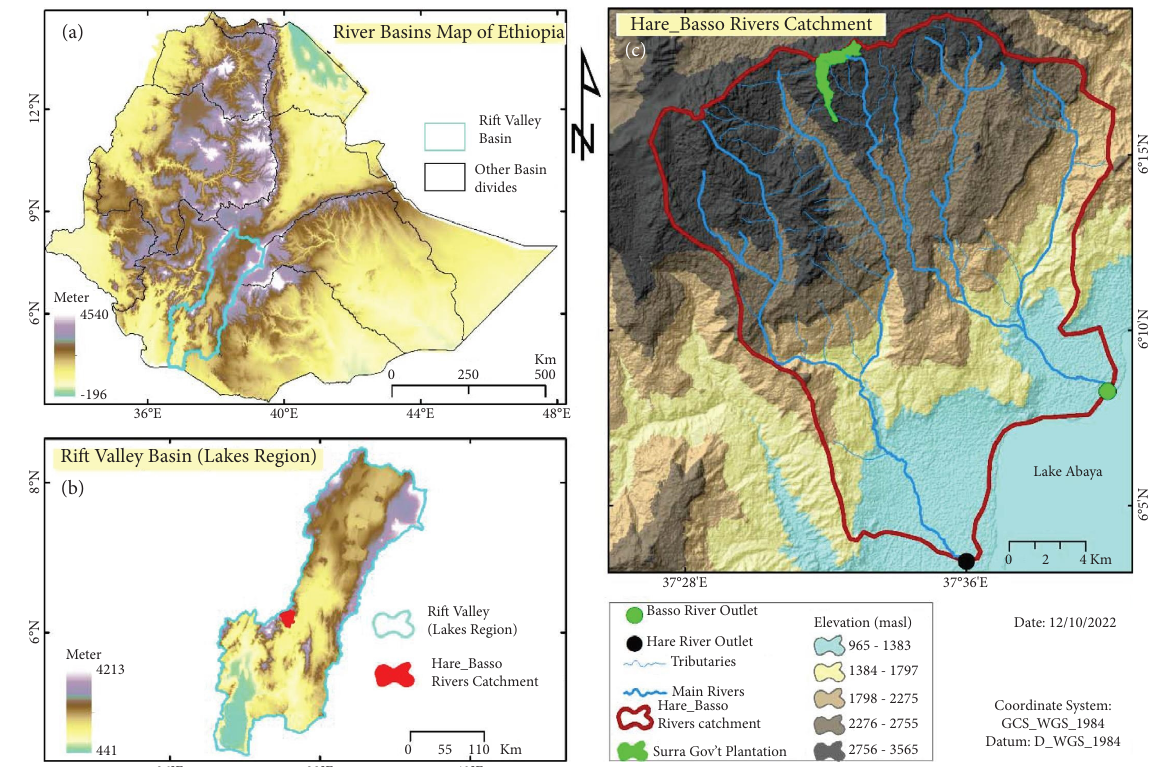
Figure 1: Te river basins of Ethiopia (a), rift valley basin (b), and upper Hare-Baso rivers catchment (c) (source: own design,